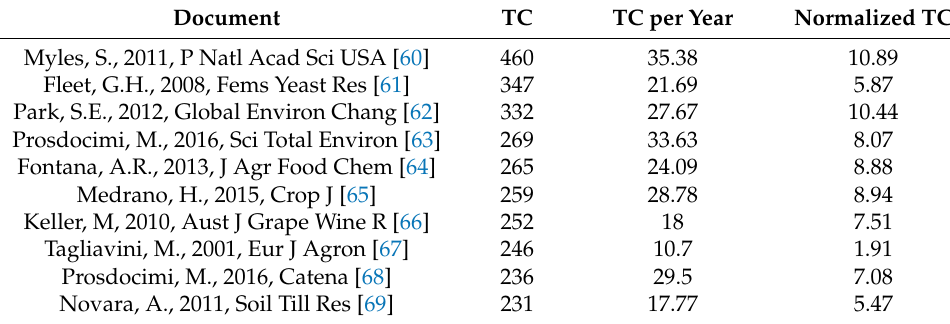
Table 5. Leading articles per number of citations.